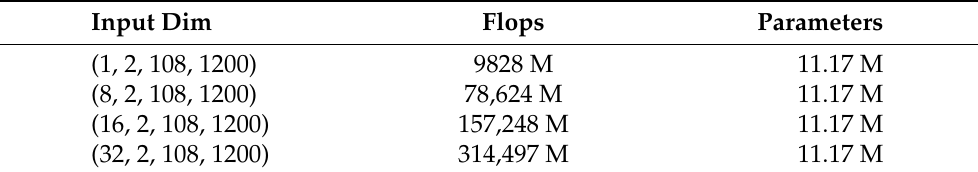
Table 1. Flops and parameters of our model. Batch-size will affect flops while parameters are fixed. The input dim is (batch-size, channel num, dim1,